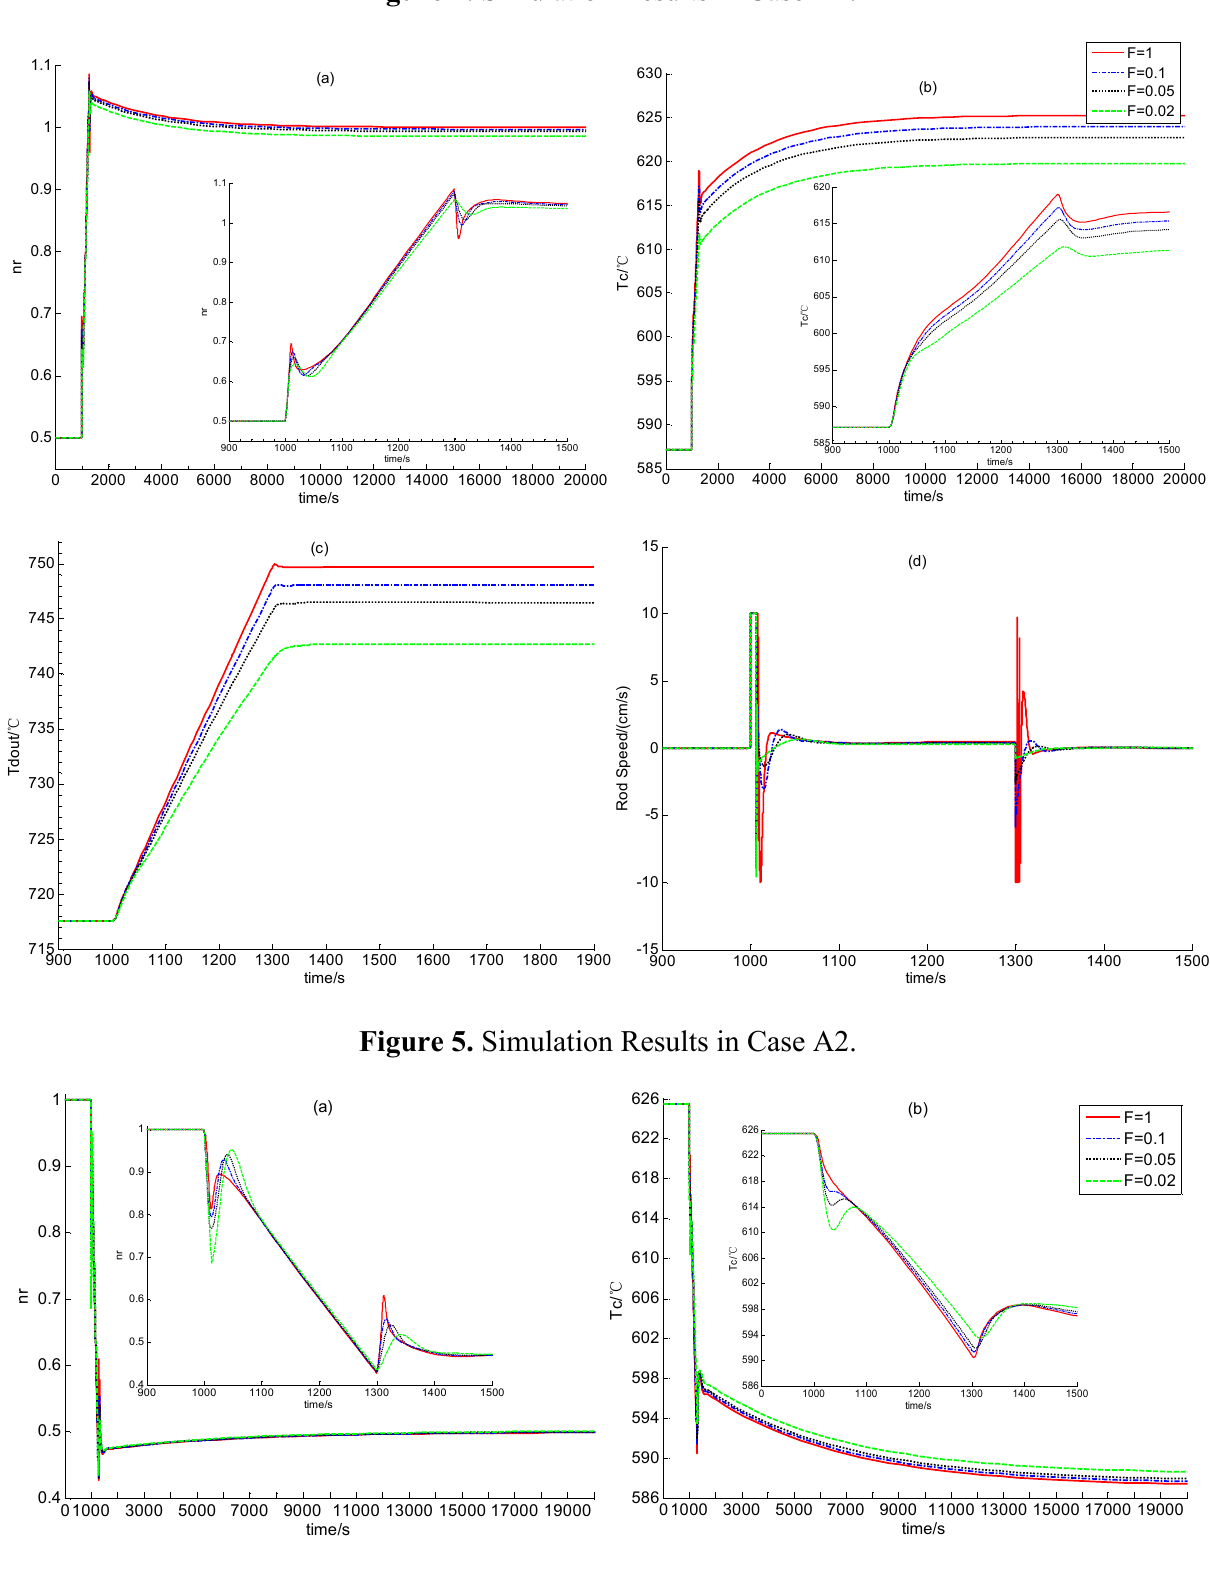
Figure 4. Simulation Results in Case A1.